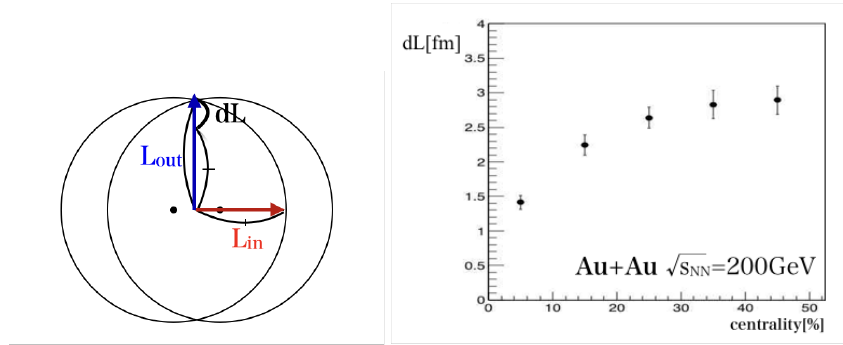
Figure 5. Left: Definition of L in , L out and dL. Right : The value of the path-length difference dL as a function of the centrality in Au + Au collisions at statistical